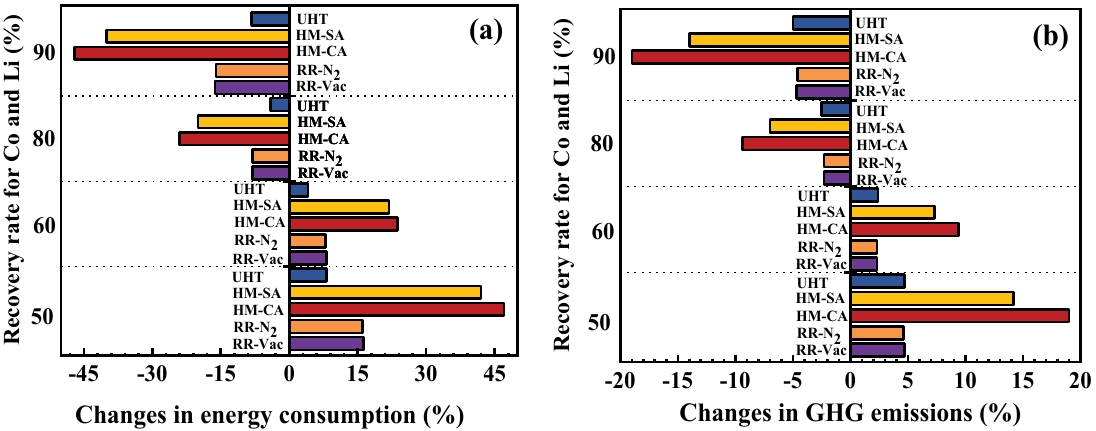
Figure 10. Sensitivity analysis of the total energy consumption ( a ) and GHG emissions ( b ) for different recycling methods by changing the recovery rate of Li and Co.